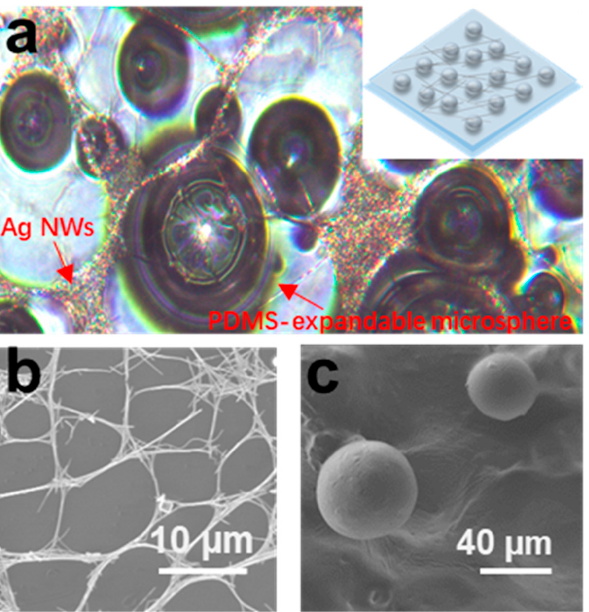
Figure 10. ( a ) Optical image of PDMS-expandable microsphere structure covered with AgNWs. The inset: Schematic image of the structure. SEM image of ( b ) the distribution of AgNWs and ( c ) the morphology of microspheres after expansion.